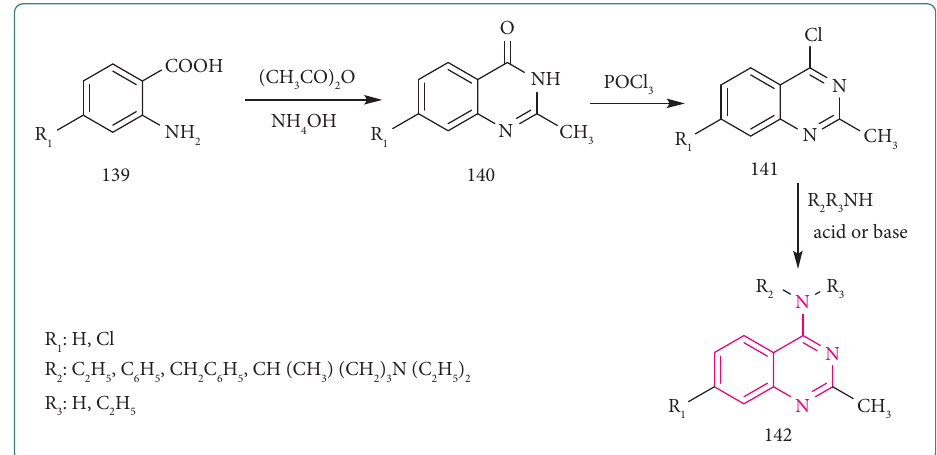
Scheme 25: Synthesis of a series of substituted 4-amino-2-methylquinazolines in the presence of (CH